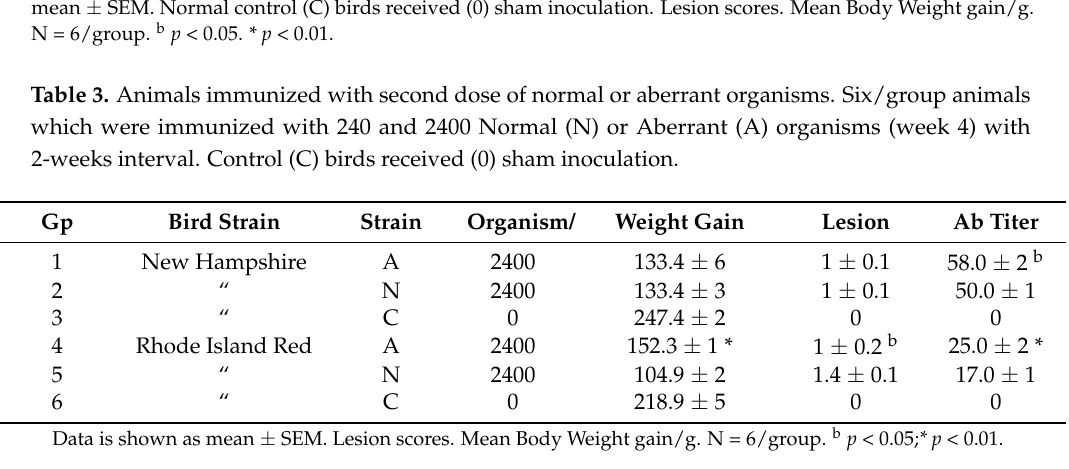
Table 4. Immunized animals with two different doses of normal or aberrant were challenged at 6 weeks of age with high numbers of infective normal organisms.